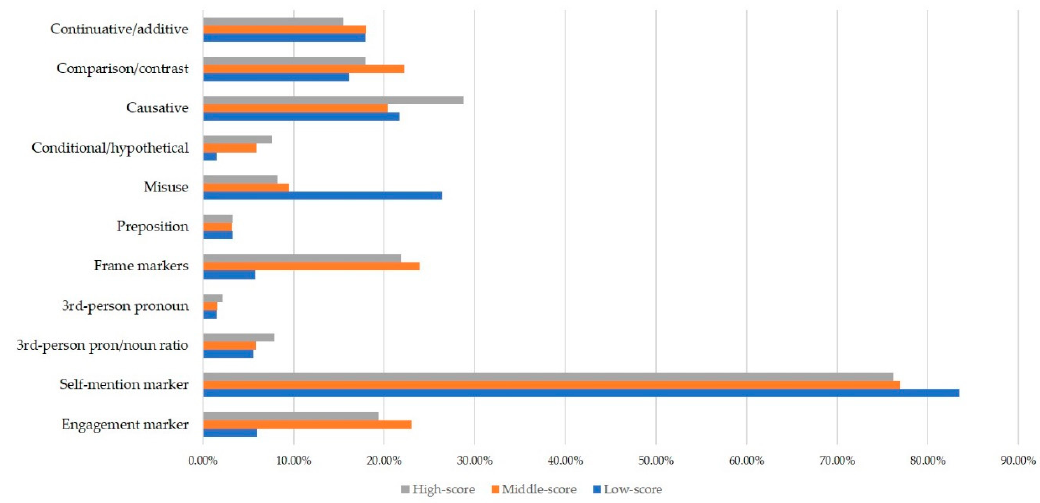
Figure 1. Use of textual organizational markers by groups. Table 4. Textual organizational measures multivariate test.